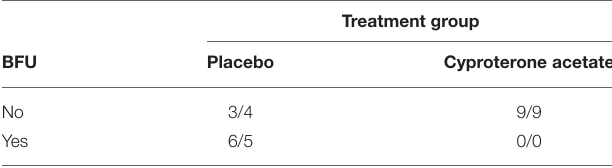
TABLE 7 | Numbers of subjects experiencing or not BFU in the two treatment groups according to the veterinarians’ scoring (first) and the owners’ impression